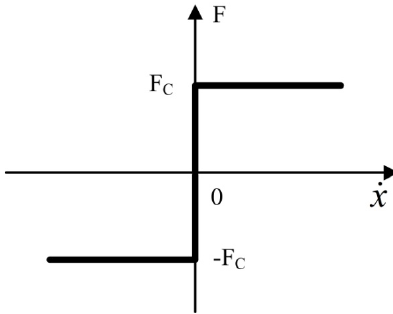
Figure 6. Coulomb friction model.